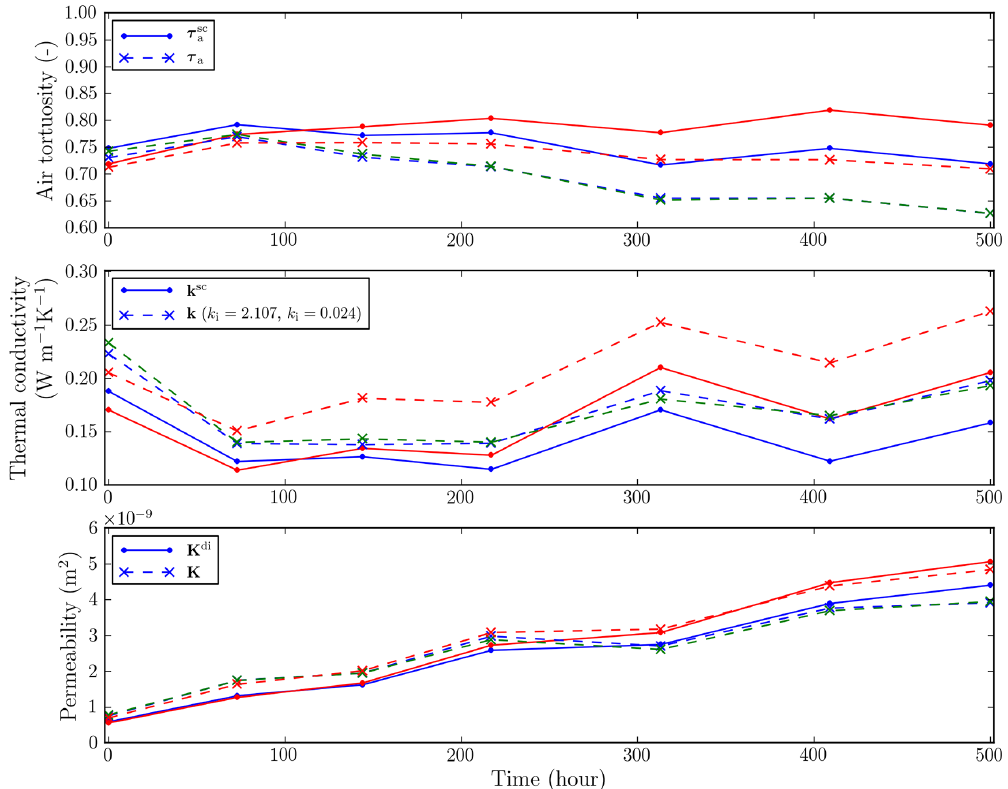
Figure 11. Time evolution of air tortuosity, thermal conductivity and permeability during the whole experiment. Comparison between values computed from 3-D images in the x , y and z directions (dashed lines in blue, green and red, respectively) and values given by analytical estimates in the xy and z directions (solid lines in blue and red,